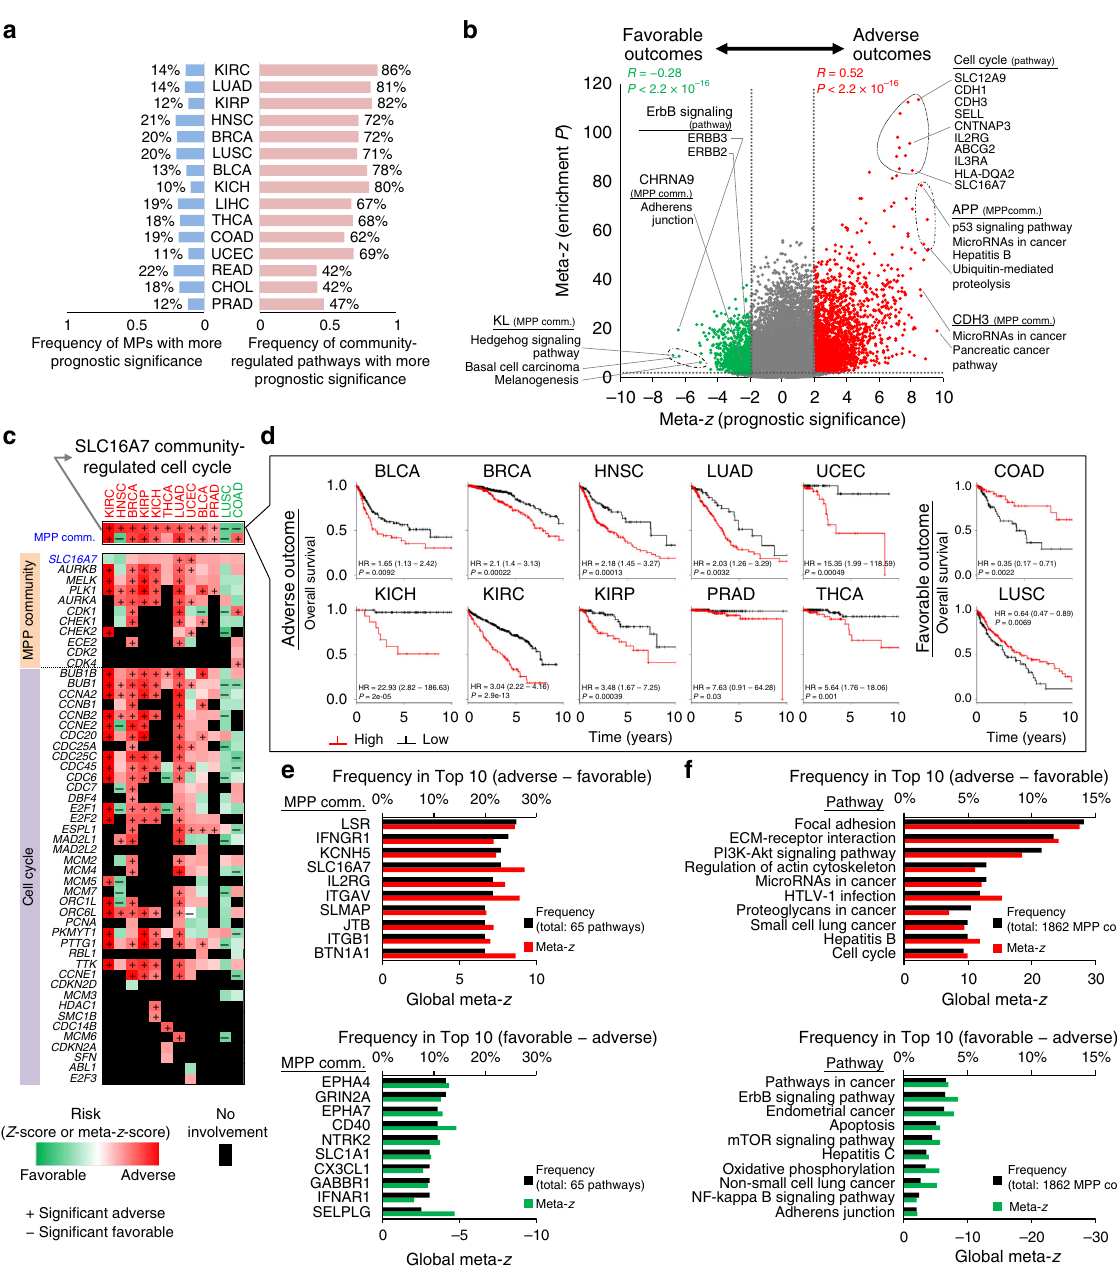
Fig. 4 Prognostic landscape of cancer membrane protein-regulated networks (CaMPNets) in 15 cancer types. a Comparison of prognostic signi fi cance between the membrane protein (MP) itself (blue) and the community-regulated pathways (pink) in 15 cancers. b Volcano plot of the meta- z -scores of adverse (red; e.g., SLC16A7 community-regulated cell cycle) and favorable (green; e.g., KL community-regulated hedgehog signaling pathway) prognostic community-regulated pathways ( x axis) versus the meta- z -scores of the enrichment P values of pathways ( y axis) across cancers. The gray dots represent non-enriched community-regulated pathways (meta- z < 1.64 or nominal one-sided P > 0.05) and insigni fi cant prognostic pathways (|meta- z | < 1.96 or nominal two-sided P > 0.05). c Heat map of SLC16A7 community-regulated cell cycles in CaMPNets showing survival outcomes of gene members in different cancer types. Statistical signi fi cances described by z -scores (or meta- z -score) for associations with adverse prognostic genes (or gene sets) are shown in red, favorable prognostic genes (or gene sets) are shown in green, and genes not involved in the CaMPNets are in black. The positive ( + ) and negative ( − ) signs indicate signi fi cant adverse and favorable prognostic genes (or gene sets) with P < 0.05 (log-rank test). d Kaplan – Meier plots representing patients strati fi ed by the auto-select best cutoff (25 – 75%) for high or low combined scores (see “ Methods ” ) of genes in the SLC16A7 community-regulated cell cycle across 12 cancers. Among the 12 cancer types, SLC16A7 community-regulated cell cycles in most cancers have signi fi cant adverse outcomes, except for colon adenocarcinoma (COAD) and LUSC, which have favorable outcomes. The 95% con fi dence intervals are displayed in parentheses. HR, hazard ratio. e The ten most frequent cancer-wide adverse (top) and favorable (bottom) prognostic MPP (an MP with binding partners) communities ( y axis) considering 65 cancer-related pathways. Notably, the frequencies of pathways for MPP communities with signi fi cant adverse and favorable outcomes are subtracted by those with signi fi cant favorable and adverse outcomes, respectively. f Top 10 frequencies of adverse (top) and favorable (bottom) prognostic pathways ( y axis) for 1862 MPP communities in 15 cancers. The global meta- z -score of each MPP community and each pathway re fl ect 65 pathways and 1862 MPP communities in all cancers, respectively. Source data are provided as a Source Data fi